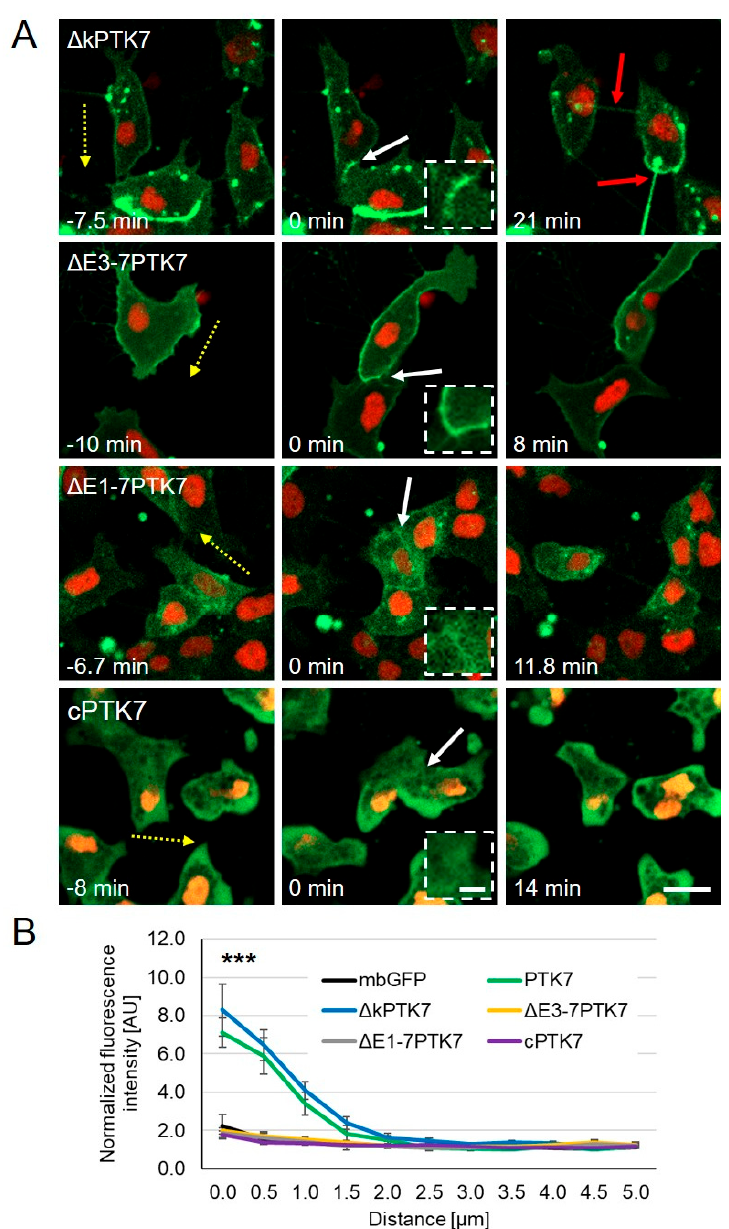
Figure 3. Dynamic localization of distinct Ptk7 deletion constructs during NC cell–cell contact. Two-cell stage Xenopus embryos were injected unilaterally with 200 pg ∆ kPTK7-GFP , 200 pg ∆ E3-7PTK7-GFP